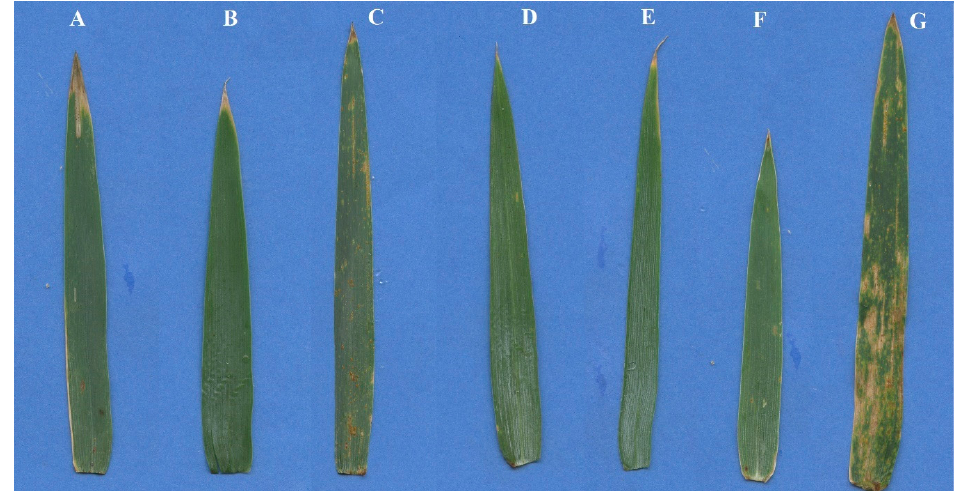
Figure 2. Symptoms of B. graminis f. sp. tritici infection on the leaves of the analyzed wheats A—cv. Torka, B—cv. Zebra, C—cv. Kontesa, D—spelt line S11, E—spelt line S12, F—spelt line S13, G—wheat x spelt line 23 (S13 × K).